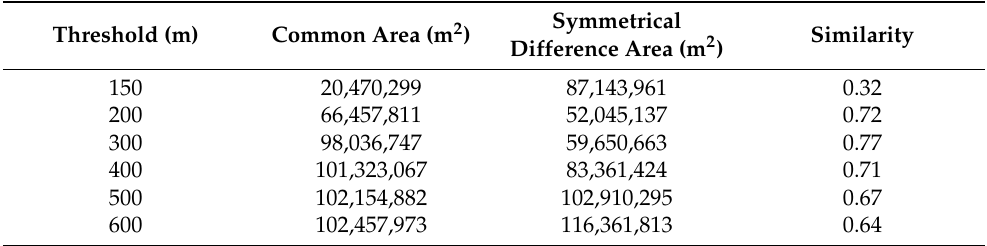
Table 3. The similarity of different kernel density analysis results and the standard 1:50K residential